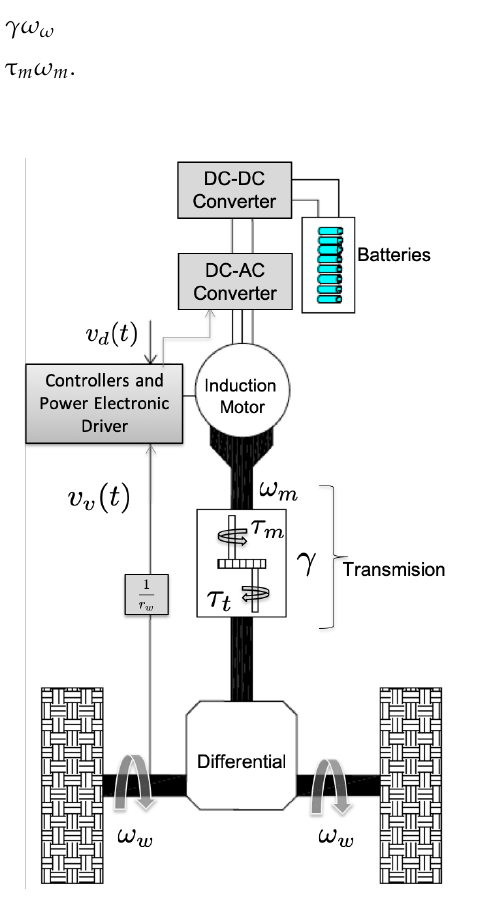
Figure 2. Subsystems that make up the electric